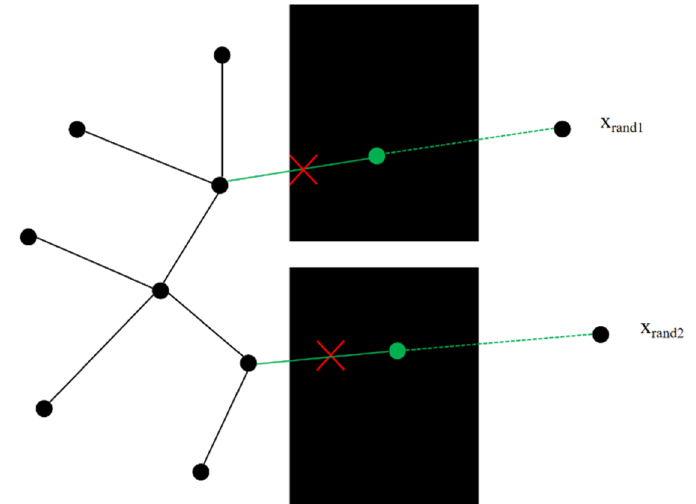
Figure 4. Schematic illustration of invalid expansions in narrow passages. x rand 1 and x rand 2 are two randomly sampling points. Since the random tree can only pass through a narrow passage, the expansions guided by x rand 1 and x rand 2 both collided with obstacles.